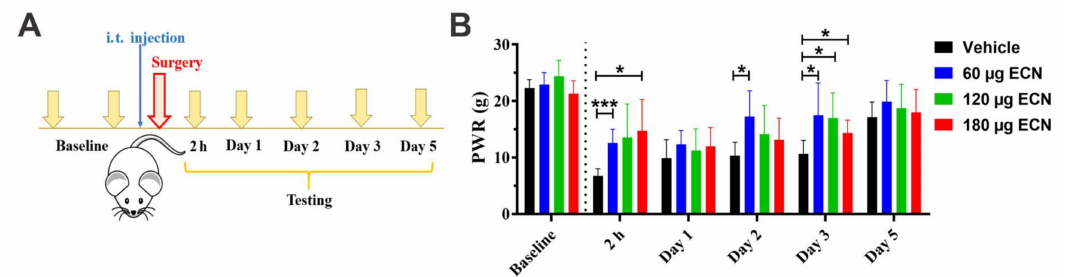
Figure 4. The preemptive administration of ECN alleviates postincisional mechanical hypersensitivity in rats. ( A ). A time-course showing presurgical baseline measurements, the timing of intrathecal (i.t.) ECN injection and post-surgical testing time points. ( B ). The preemptive i.t. application of ECN alleviated post-incisional mechanical hypersensitivity in rats in a dose-dependent manner ( n = 9 for Vehicle; n = 8 for 60 µ g, n = 7 for 120 µ g and n = 8 for 180 µ g ECN groups). Each data point is represented as mean + SD. * p < 0.05 and *** p < 0.001 vs. Vehicle group, Two-way RM ANOVA followed by Tukey’s post hoc